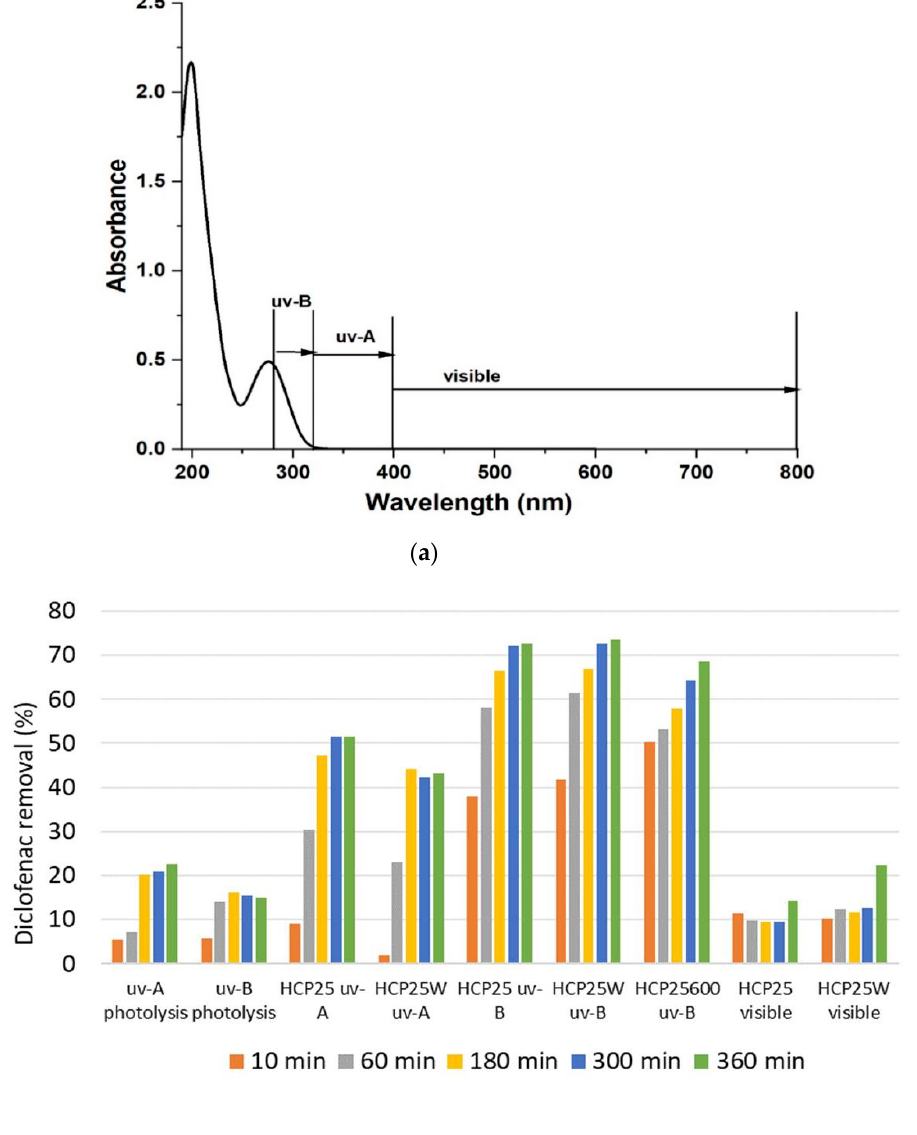
Figure 9. ( a ) Absorption spectra of diclofenac sodium and ( b ) diclofenac removal using different light sources and prepared composites. The deviation of the mean of measurement points based on the repeated experiments is ~1%. Relative error of analysis is 0.2% and standard error of calibration of the UV–VIS device is